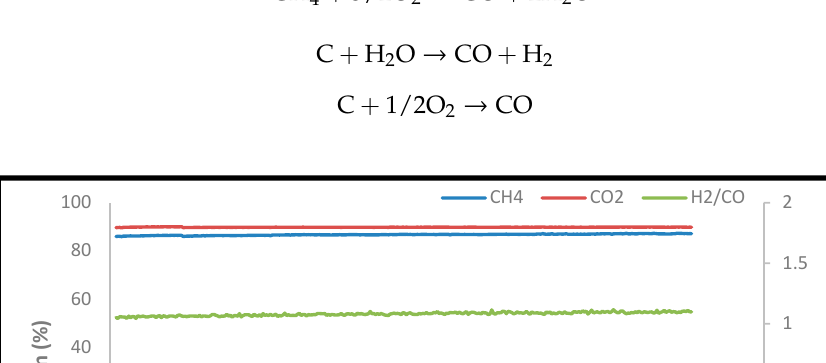
Figure 15. DRM reaction of the Ni,Pd,Pt/Mg 0.85 Ce 4+0.15 O catalyst with a reaction conditions: T = 900 °C, CH 4 /CO 2 ratio of 1:1, 1.25% O 2 , and GHSV = 15,000 mL h − 1 g − 1 cat. Figure 14. TEM analysis of the spent catalyst Ni,Pd,Pt/Mg 0.85 Ce 4+0.15 O after reaction at T = 900 °C with